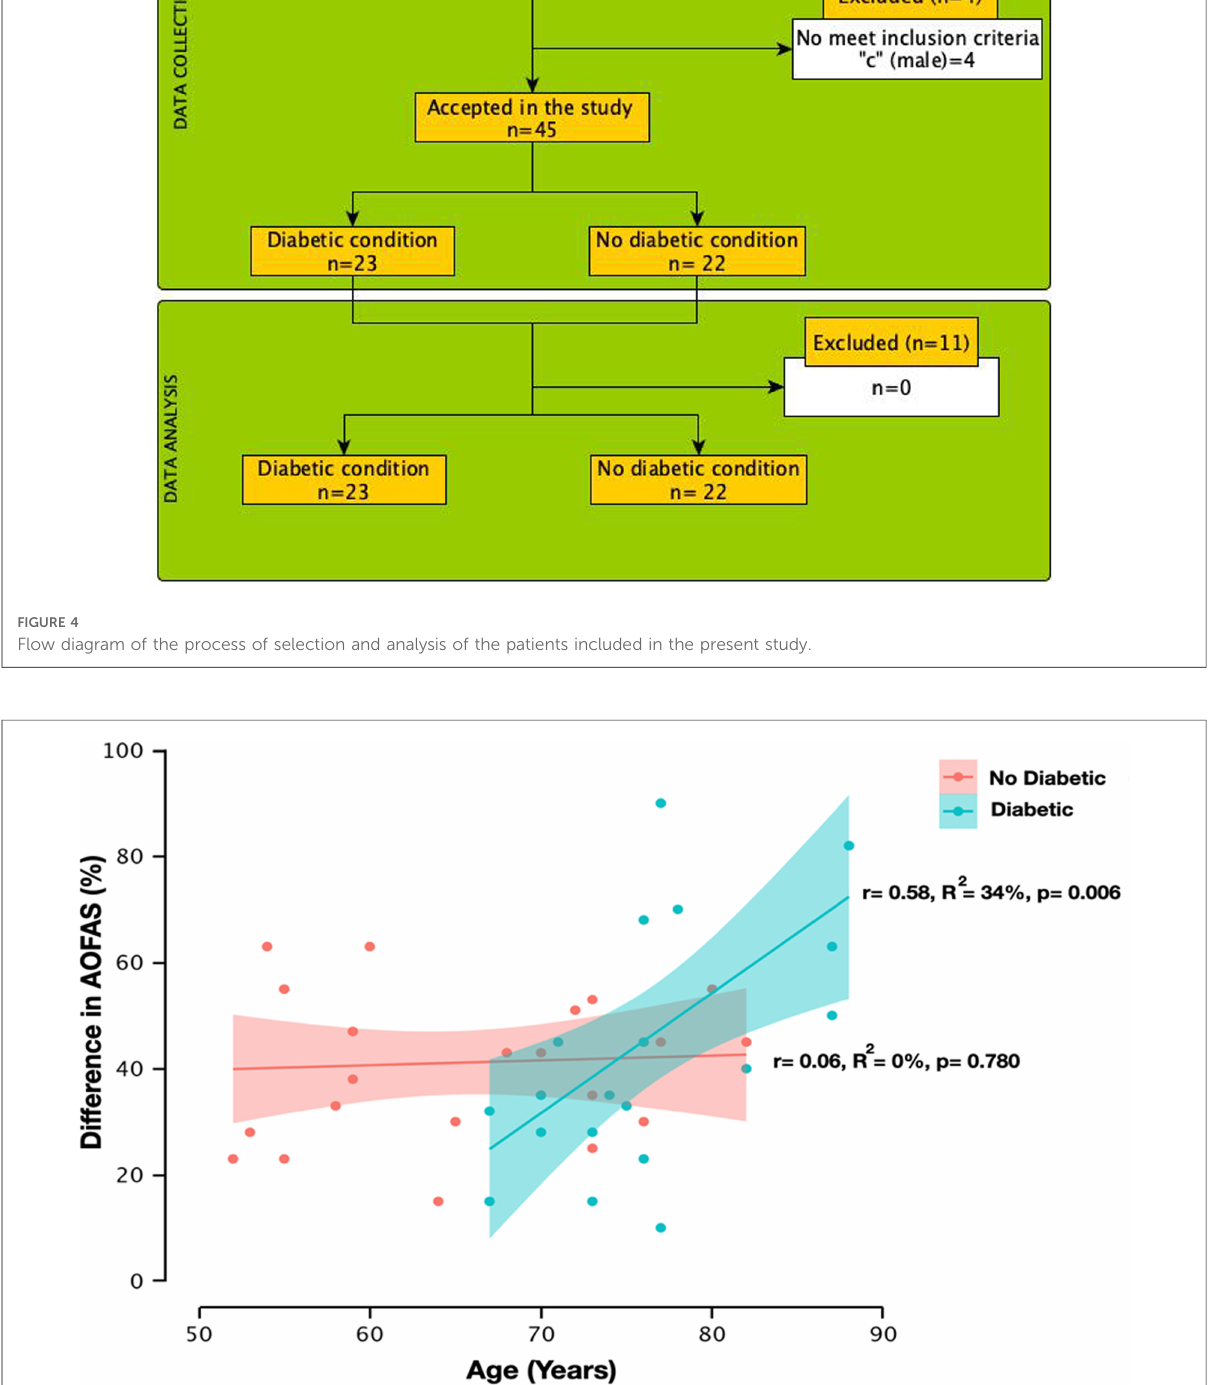
FIGURE 5 Relationship between American Orthopedic Foot and Ankle Surgery Society (AOFAS) test difference scores and age as a function of patients ’ condition (i.e., diabetic vs. non-diabetic). The red dots re fl ect the AOFAS test difference scores in the non-diabetic condition, while the green dots re fl ect the AOFAS test difference scores in the diabetic condition. The shaded portion around the regression line re fl ects the 95% con fi dential interval. r =Pearson ’ s correlation coef fi cient, R 2 =coef fi cient of determination, p = p